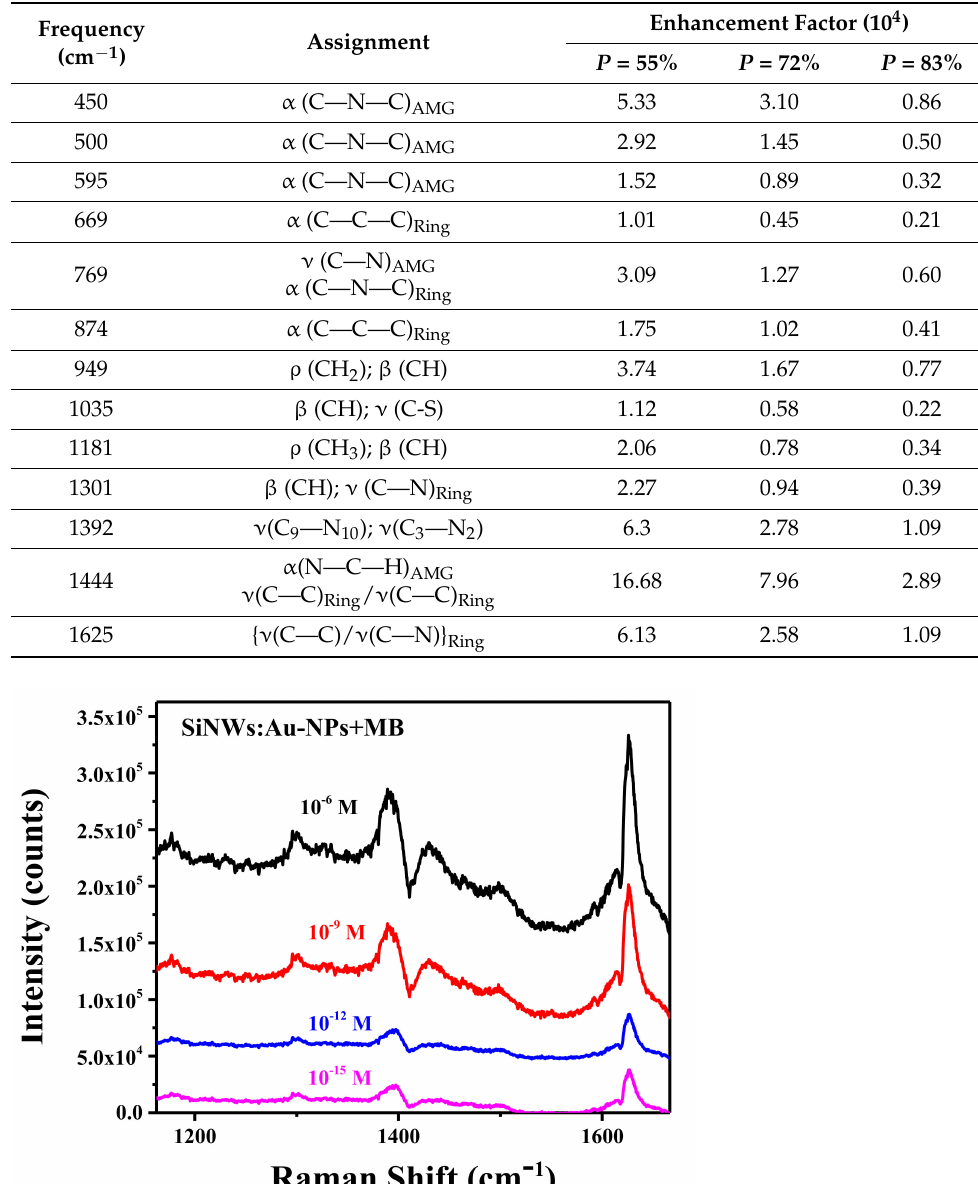
Table 1. Enhancement factor for selected Raman lines of MB (10 − 6 M) in samples of SiNWs:Au-NPs with different porosity, P . The assignment of the Raman lines is performed according to Ref. [47].